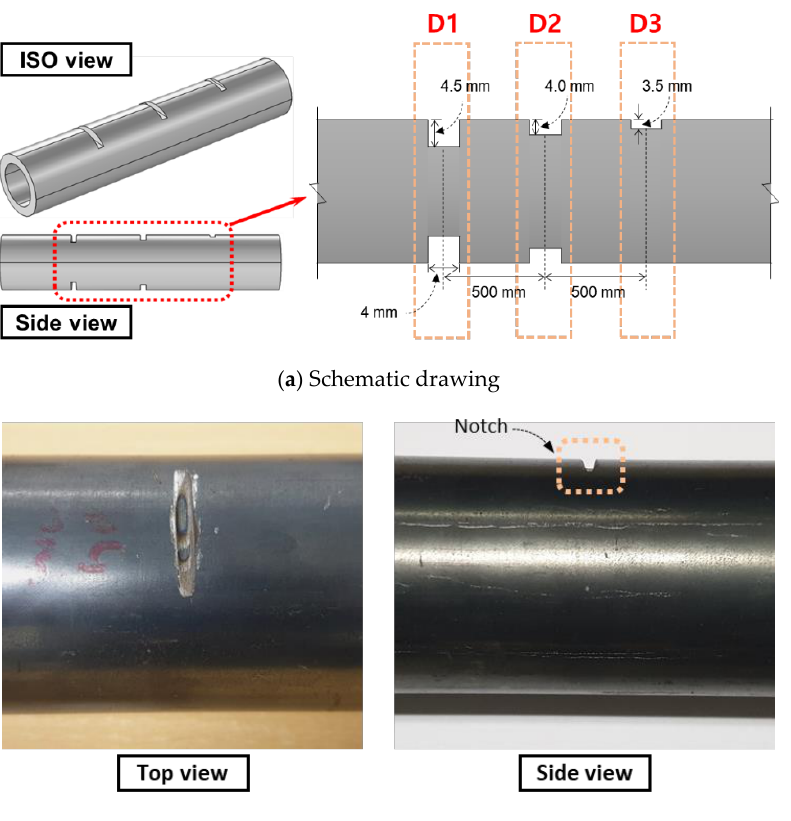
Figure 13. Defected specimen.